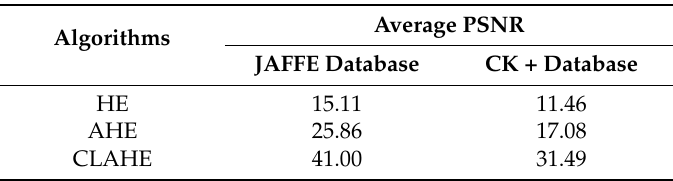
Table 1. The peak signal to noise ratio (PSNR) values for different algorithms. HE—histogram equalization; AHE—adaptive HE; CLAHE—contrast limited AHE. Algorithms